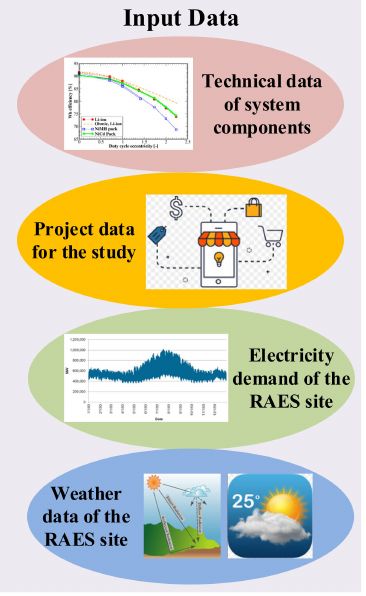
Figure 6. Input data for the optimal sizing procedure of RAES